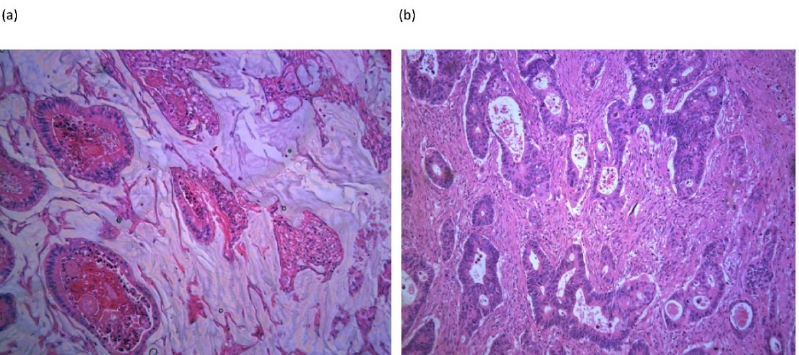
Figure 1. Representative histological slides of: ( a ) mucinous colorectal adenocarcinoma displaying abundant extracellular mucin in a 61 year old male patient with a pT4N2 mucinous rectal tumor. ( b ) Non-mucinous colorectal adenocarcinoma in a 67 year old female patient with a pT3N1 rectal tumor. H&E-stained section, 10× magnification, imaged with Leica DM 4000B microscope (Leica Microsystems, Mannheim, Germany).